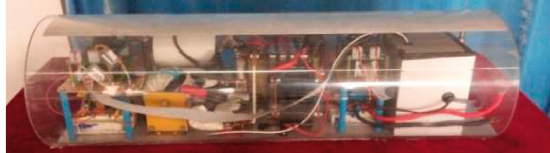
Figure 20: Waveforms of primary and secondary voltages and current of transformer under heavy load.